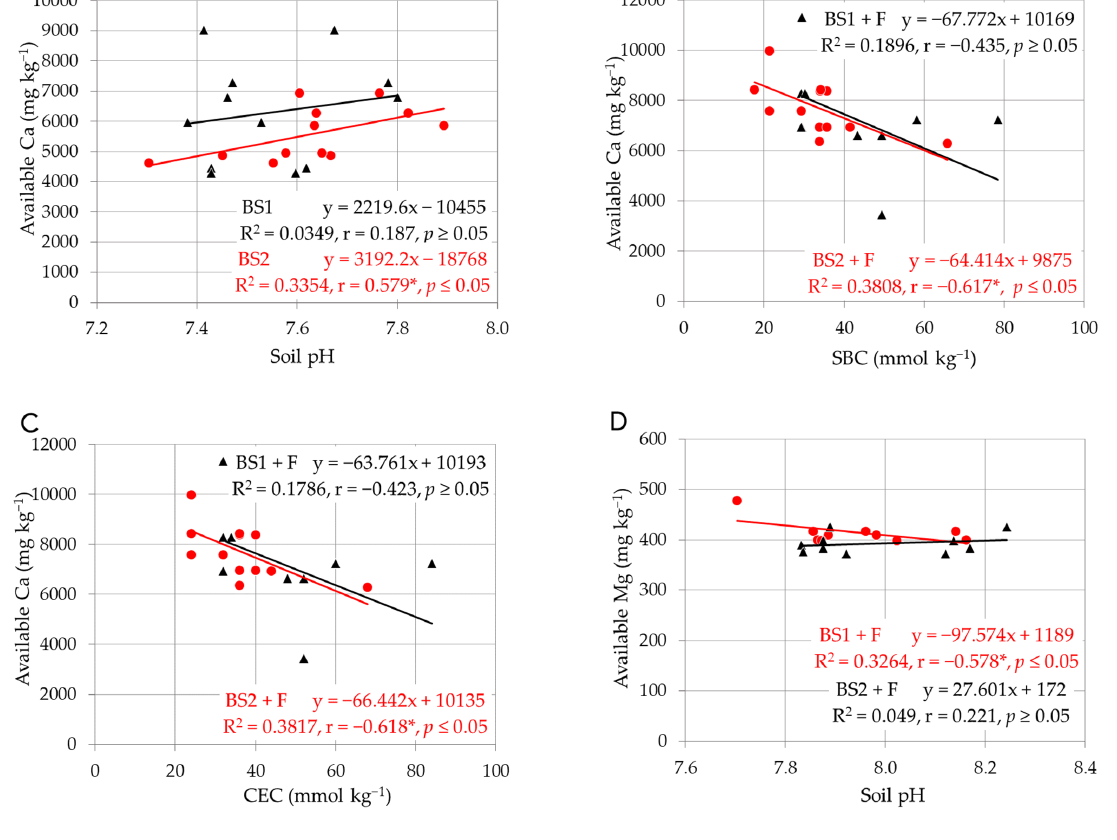
Figure 3. The linear dependence between selected soil properties and Ca availability for chosen treatments in sandy soil: ( A ) Soil pH in nonfertilized treatments; ( B ) Sum of basic cations (SBC) in fertilized treatments; ( C ) Cation exchange capac- ity (CEC) in fertilized treatments. The linear dependence between selected soil properties and Mg availability for chosen treatments in loamy soil: ( D ) Soil pH in fertilized treatments; ( E ) Sum of basic cations (SBC) in fertilized treatments. Red circles and * indicate correlation at p ≤ 0.05.